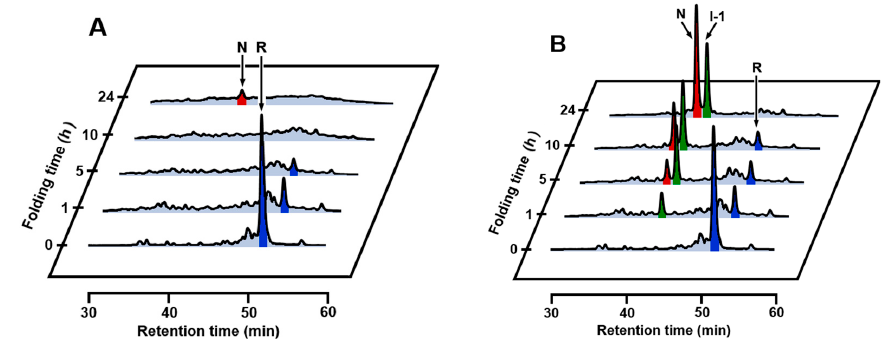
Figure 9. RP-HPLC chromatograms obtained by the oxidative folding of α LA using 1 eq DHS ox at pH 8.0 and 5 °C in the absence or presence of GdmCl. The initial concentration of R was 10 µM. The folding intermediates were trapped at different reaction times by acidification. ( A ) in the presence of 0.625 M GdmCl; ( B ) in the presence of 0.625 M GdmCl and 5 mM CaCl 2 .